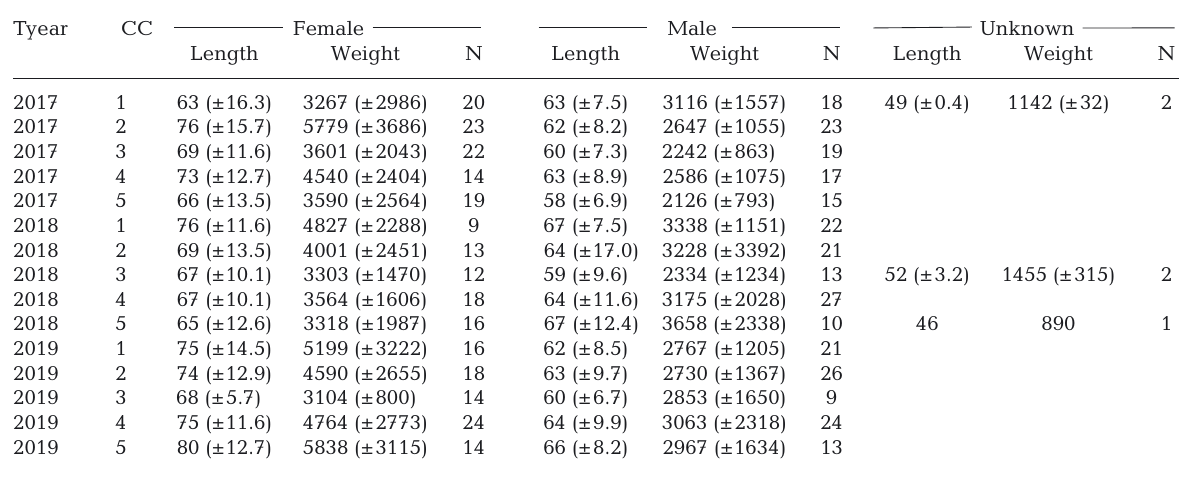
Table 1. Physical data for the acoustically tagged cod (n = 536). Mean (±SD) length (nearest cm), mean weight (nearest g) and numbers tagged in each year (Tyear) are provided for the different catch clusters (CC): CC1: Glasøysvaet; CC2: Lauvøysvaet; CC3: Araneset; CC4: Åkvika; and CC5: Dromnessundet. Fish are separated by sex (females, males, and unknown); empty cells: no available